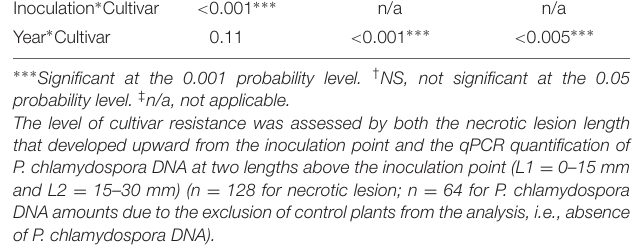
between cultivar and year ( Table 1 and Supplementary Table